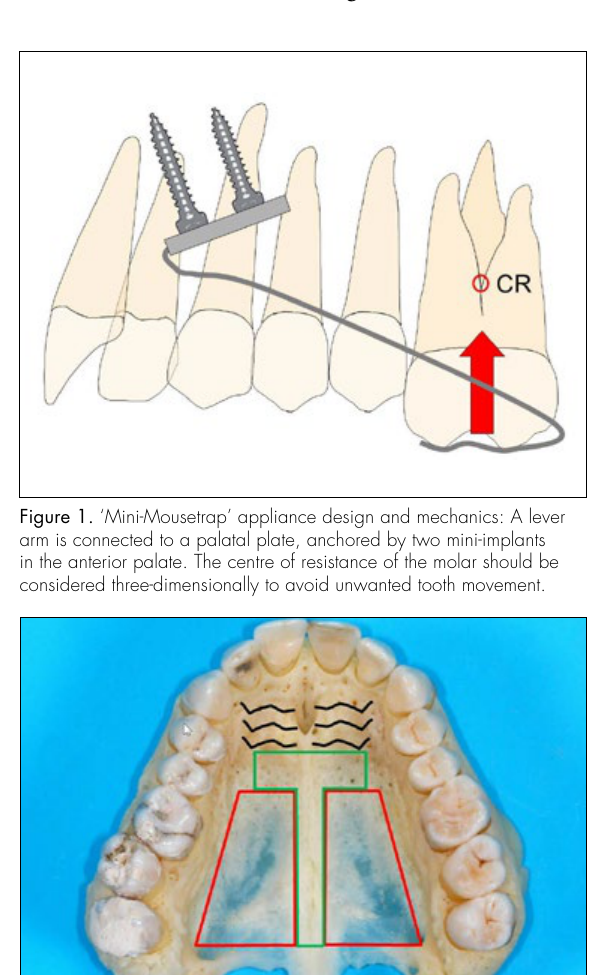
Figure 2. T-Zone: Recommended insertion site posterior to the palatal rugae. Bone is too thin in posterior and lateral areas.